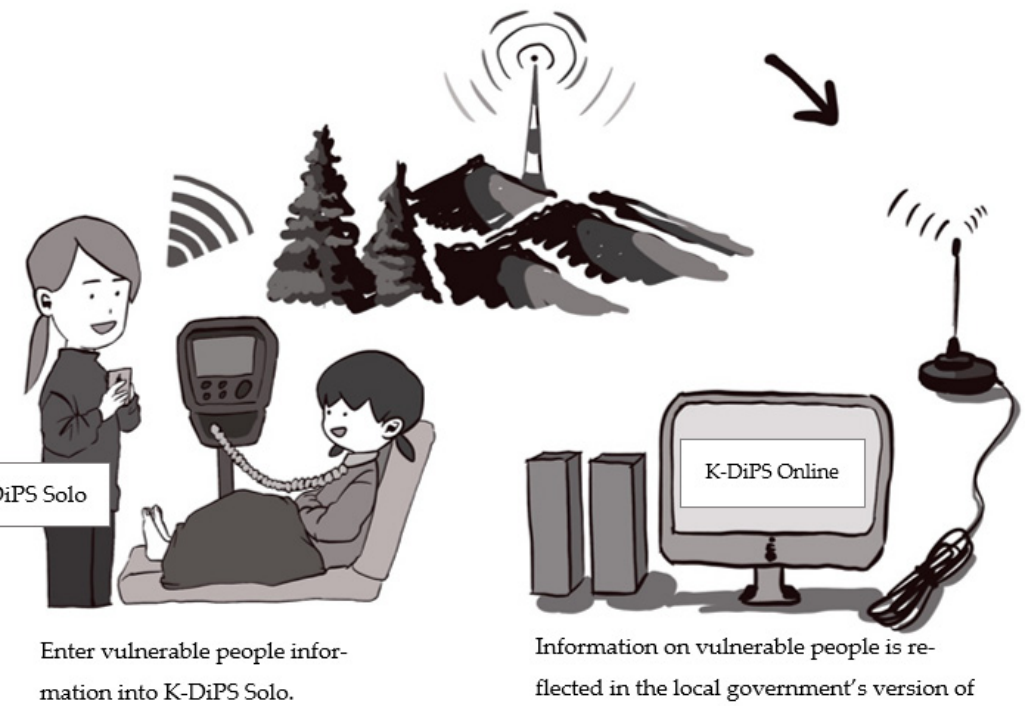
Figure 1. Operational process of KDS and KDO.